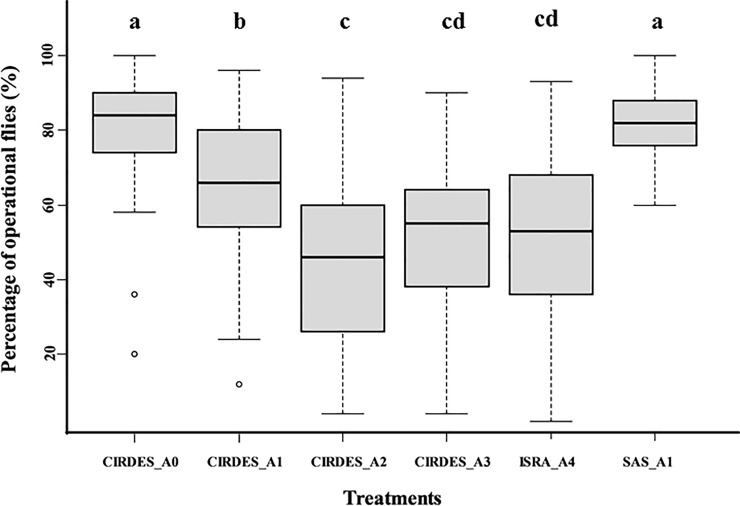
Percentages of operational flies (%) according to treatment (A0 to A4) and site where the test was performed.Boxes extend between the 25th and 75th percentile. A thick line denotes the median. The whiskers extend up to the most extreme values, and white circles represent outlier data. Different letters highlight significant differences (P < 0.05).